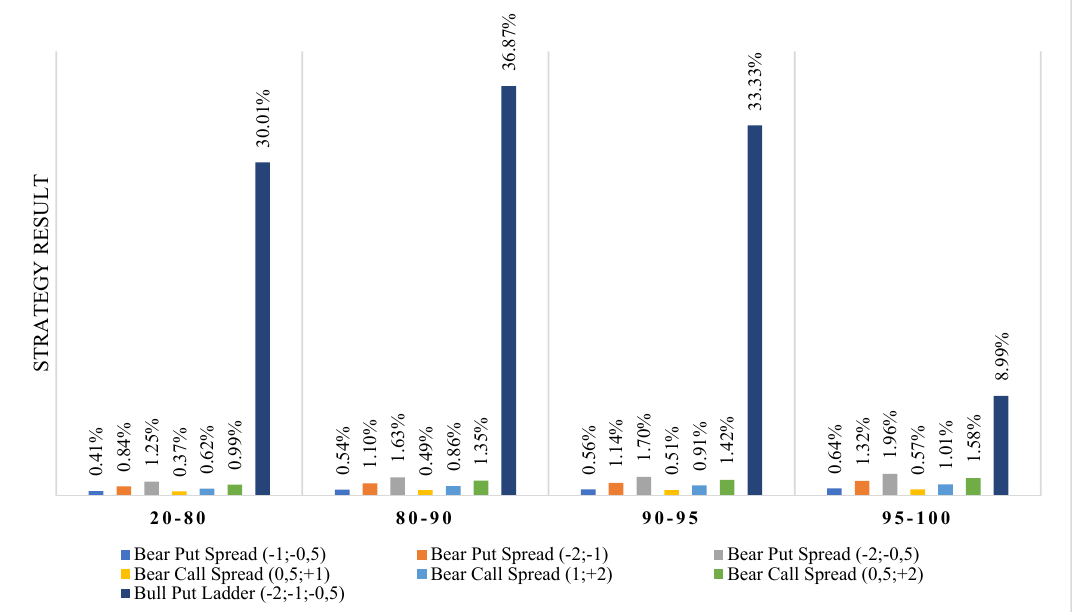
Figure 7. Bear put spread, bear call spread, and bull put ladder results for declines of WTI Crude Oil prices ranging from 10% to 20%.